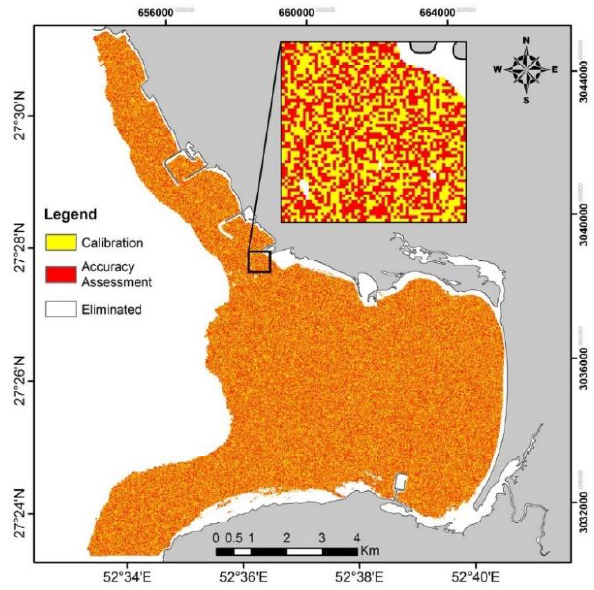
Figure 3. Randomly selected pixels from L8/OLI image to conduct calibration (red pixels) and accuracy assessment of the models (yellow pixels). The white pixels are the shallow areas or clouds that are masked from calculations.